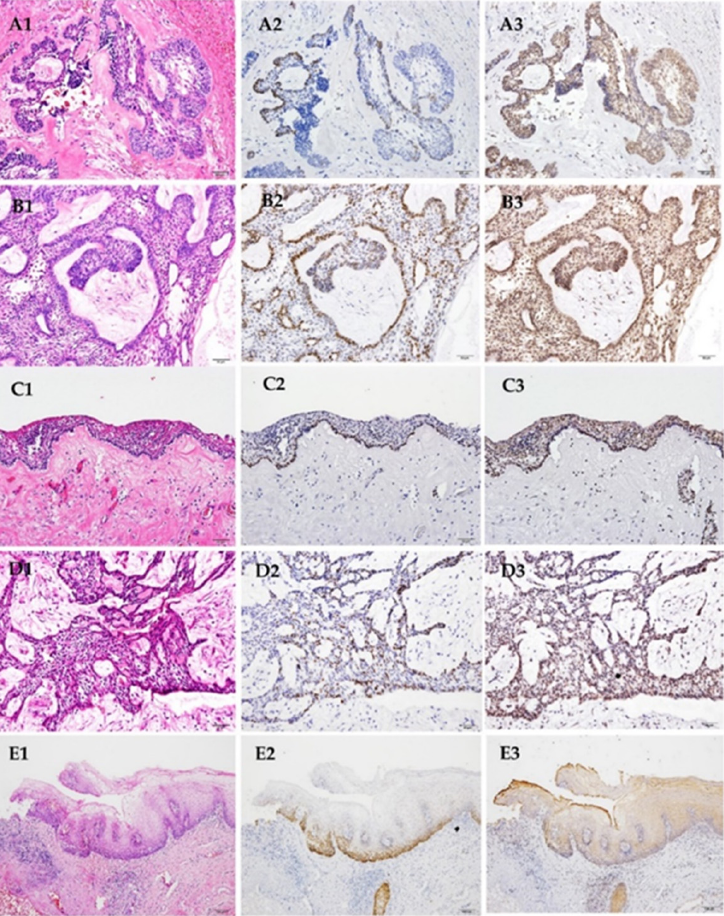
Figure 1. Different types of ameloblastoma with hematoxylin and eosin (H&E) stain and immunohistochemical stains (IHC). Histopathological subtypes were as followed: follicular ( A1 – 3 ), plexiform ( B1 – 3 ), and unicystic ( C1 – 3 , D1–3 ). The ( D ) series are the intraluminal portion of a unicystic ameloblastoma. The ( E1 – 3 ) are normal oral squamous epithelium including in the specimen, serving as an internal positive control. ( A2 , B2 , C2 , D2 , E2 : 1:100 dilution (Cell Signaling); A3 , C3 , D3 , E3 : 1:1000 dilution (Millipore); B3 : 1:500 dilution (Millipore). Original magnification × 200 in A – D ; × 100 in E ).